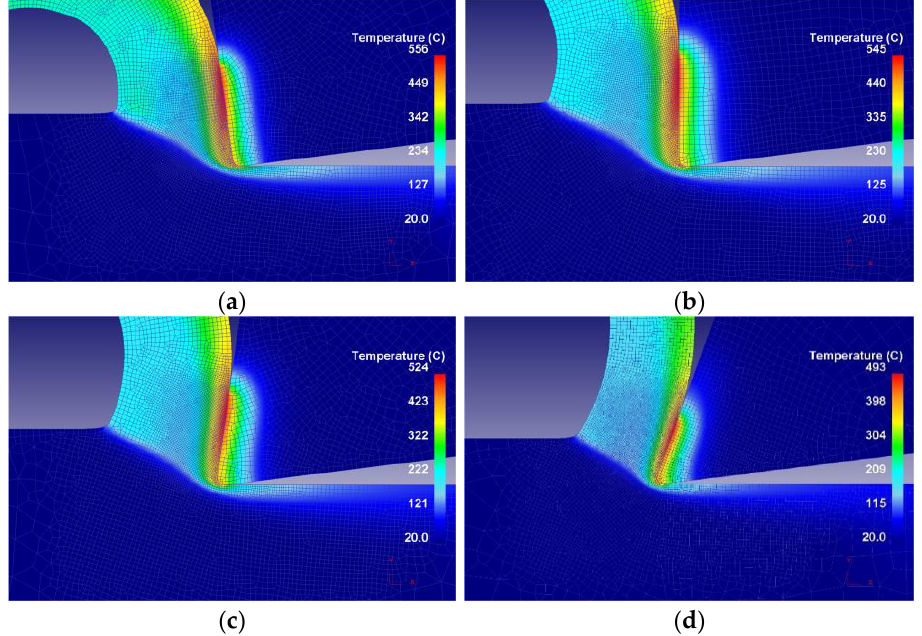
( d ) Figure 11. Force distribution during cutting process for different rake angles (α = 7° and 𝑟 𝜀 = 20 µm): ( a ) −8–0°, ( b ) 0–8°, ( c ) 8–17.5°, and ( d ) 17.5–20°. The simulation results of the tool temperature are shown in Figure 12. It is clearly observed that the maximum tool temperature occurs at the rake face of the tool. As noted, the negative rake angle produces more heat which decreases while the values of the rake angle are augmented. Since the tool–chip contact area becomes much larger compared to